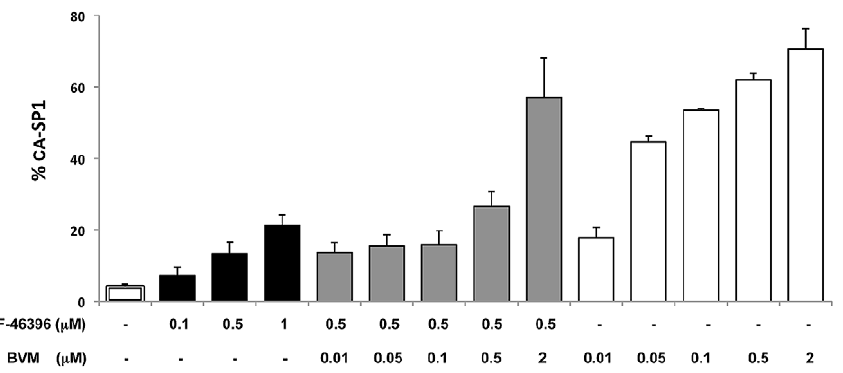
Figure 3. PF-46396 interferes with BVM activity at low BVM concentration. 293T cells were transfected with WT pNL4-3 and treated with either PF-46396 alone, BVM alone, or PF-46396 + BVM at the indicated concentrations. Levels of CA-SP1 in virion fractions were evaluated by